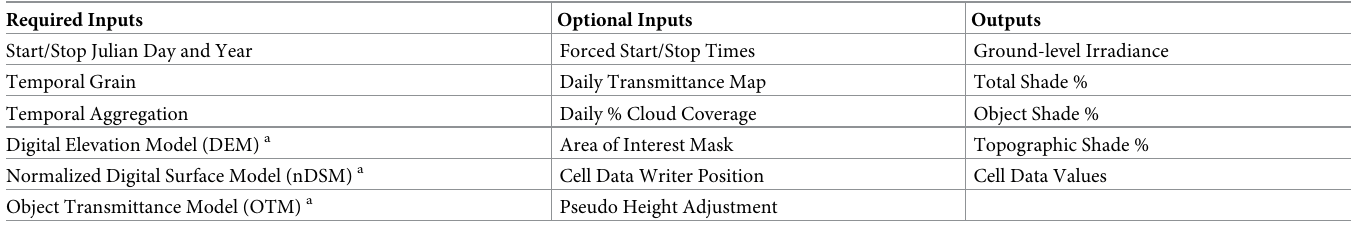
Table 1. List of Penumbra inputs, parameters, and